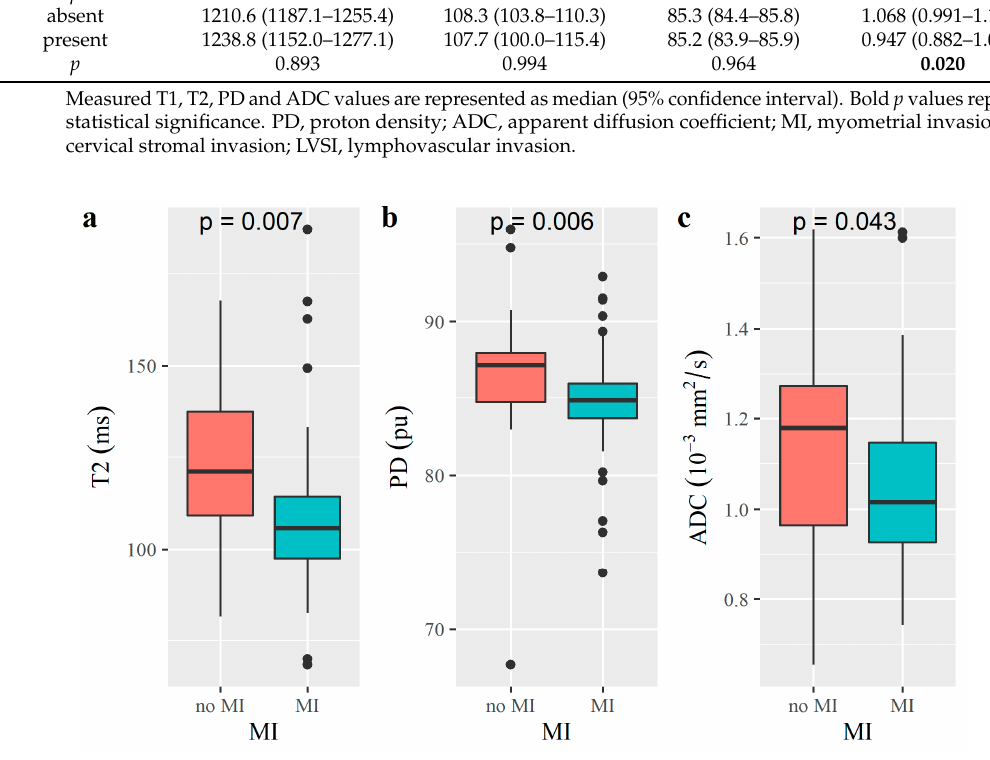
Figure 4. Boxplots of findings with representative significant differences ( p < 0.05) of T2 ( a ), PD ( b ) and ADC ( c ) in patients with or without